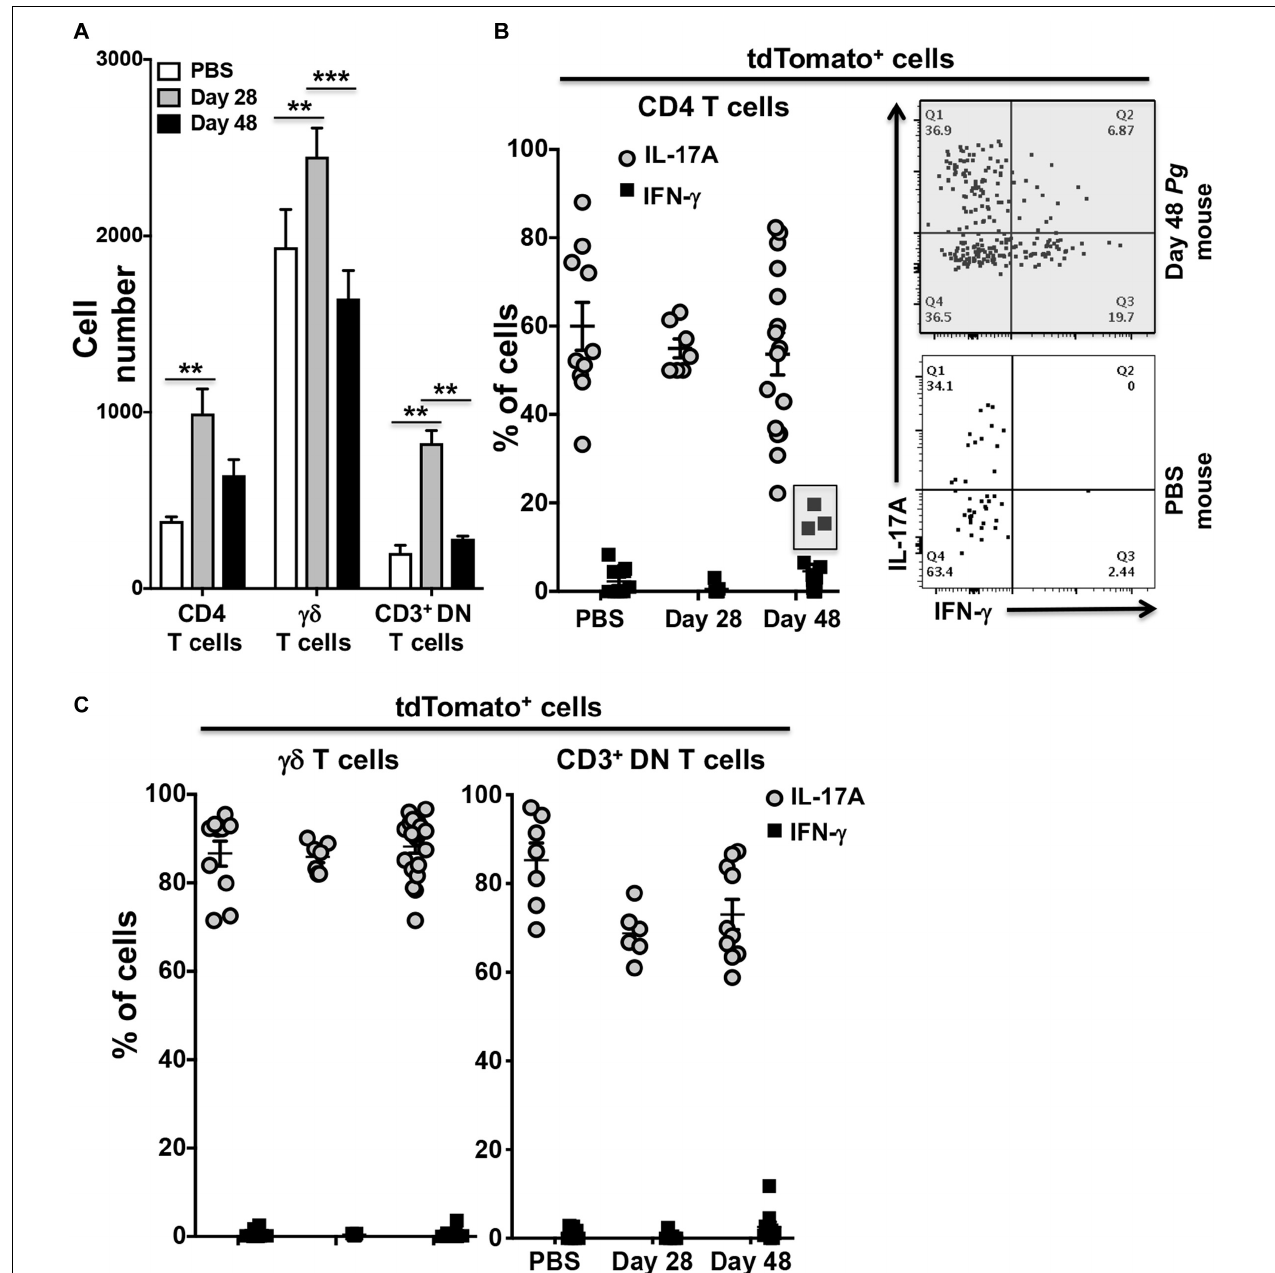
FIGURE 4 | Expression of IFN- γ by tdTomato + CD4 + T cells present within the oral mucosa of P. gingivalis inoculated mice is sporadic. IL-17A cre fate-tracking mice were pre-treated with SMZ and then orally inoculated with either P. gingivalis (4 × 10 9 cfu per ml) or vehicle (PBS). At day 28 or 48 oral mucosa was harvested and single-cell suspensions from single mice treated and stained with mAbs as described in Figure 3 . (A) Summary data of total numbers of CD4 + T cells, CD3 + DN T cells and γδ T cells found in the oral mucosa of mice after 28 or 48 days. Cell types were identified from single cell suspensions as described in Figure 3 . Cell numbers were normalized to 100,000 live non-immune cells to account for potential cell loss during processing and counting. Data are from 3 experiments with at least 2 mice per time point and are plotted with means ± SEM. Means analyzed by two-tailed Student’s t -test. ** p < 0.01, *** p < 0.001. (B) Summary data showing individual data points from three experiments examining the frequency of IL-17A and IFN- γ expression in IL-17A cre -tdTomato + CD4 + T cells recovered from the oral mucosa of IL17A fate-tracking mice. Representative flow cytometry plots from a single PBS and P. gingivalis inoculated mouse at day 48 showing evidence of IFN- γ expression in IL-17A cre -tdTomato + CD4 + T cells. (C) Summary data showing individual data points from three experiments examining the frequency of IL-17A and IFN- γ expression in IL-17A cre -tdTomato + CD3 + DN T cells and γδ T cells recovered from the oral mucosa of IL-17A cre fate-tracking mice.